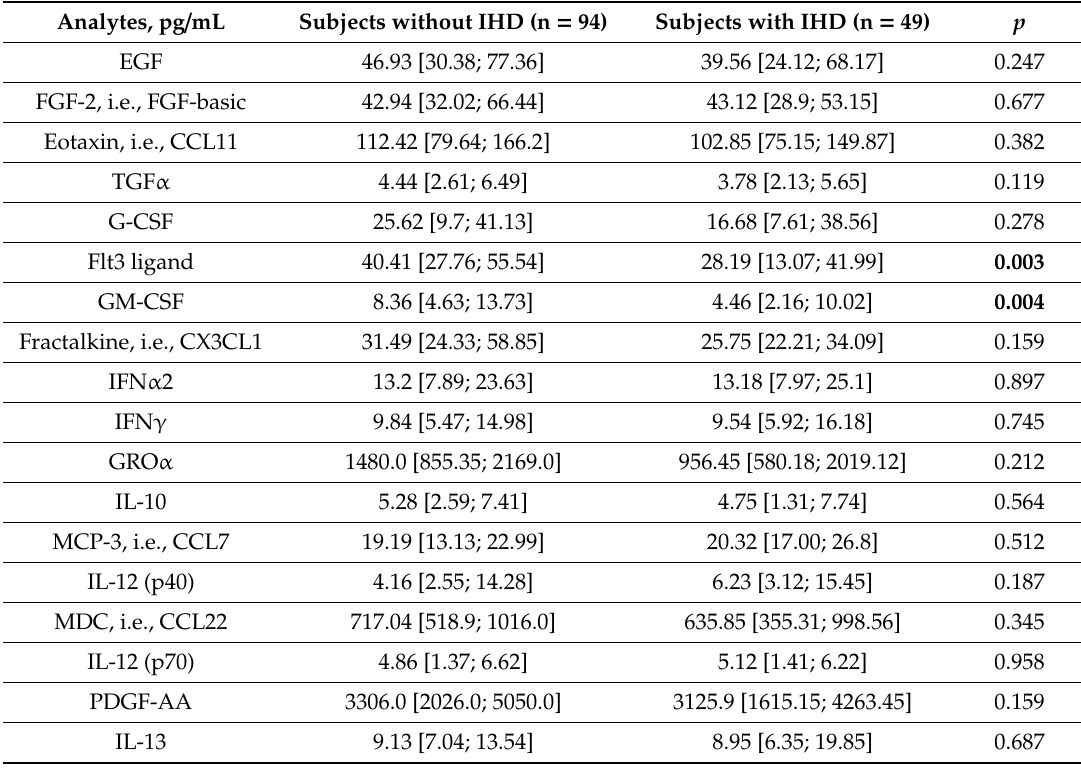
Table 2. Levels of the analyzed human cytokines / chemokines in IHD (median (lower; upper quartile)). Analytes, pg /